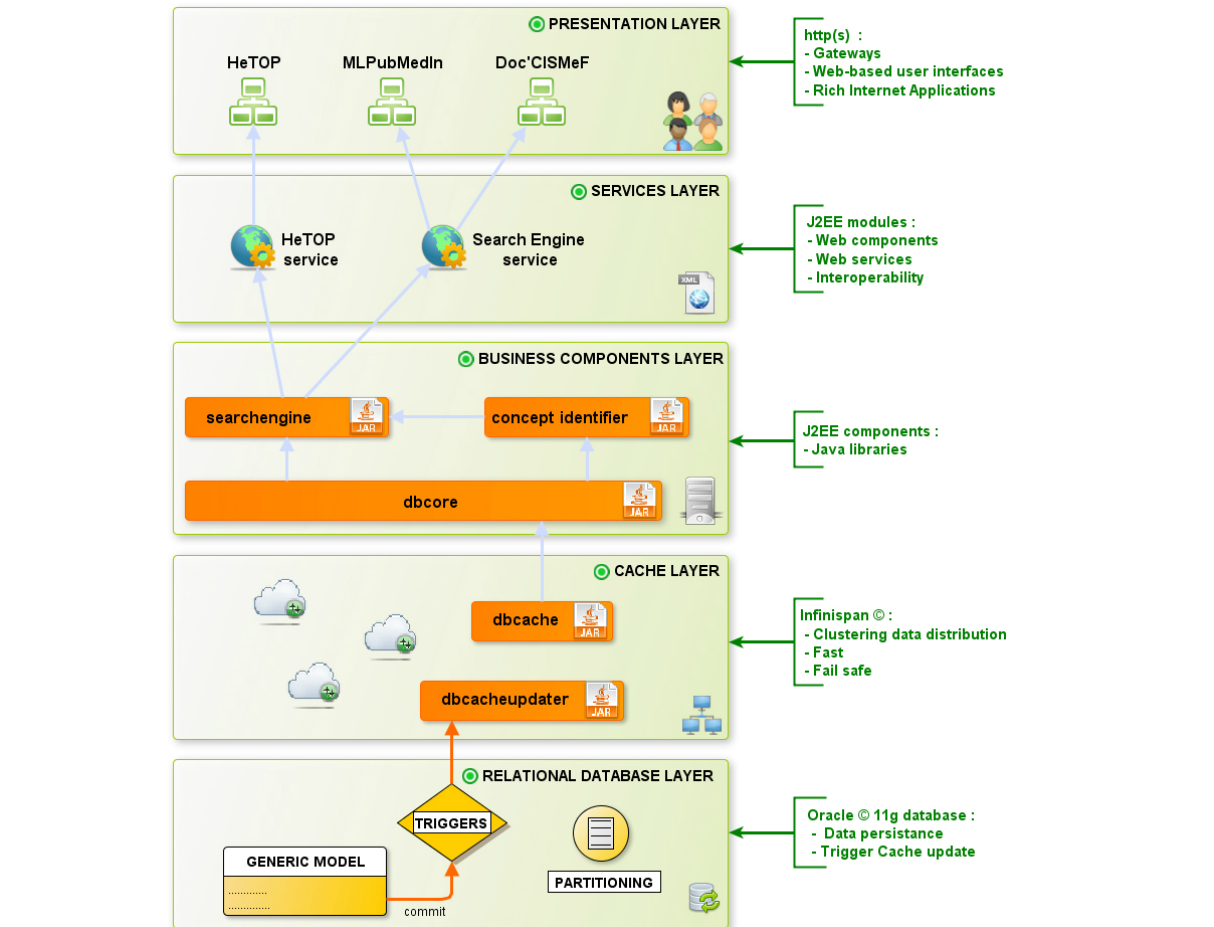
Figure 1. CISMeF information